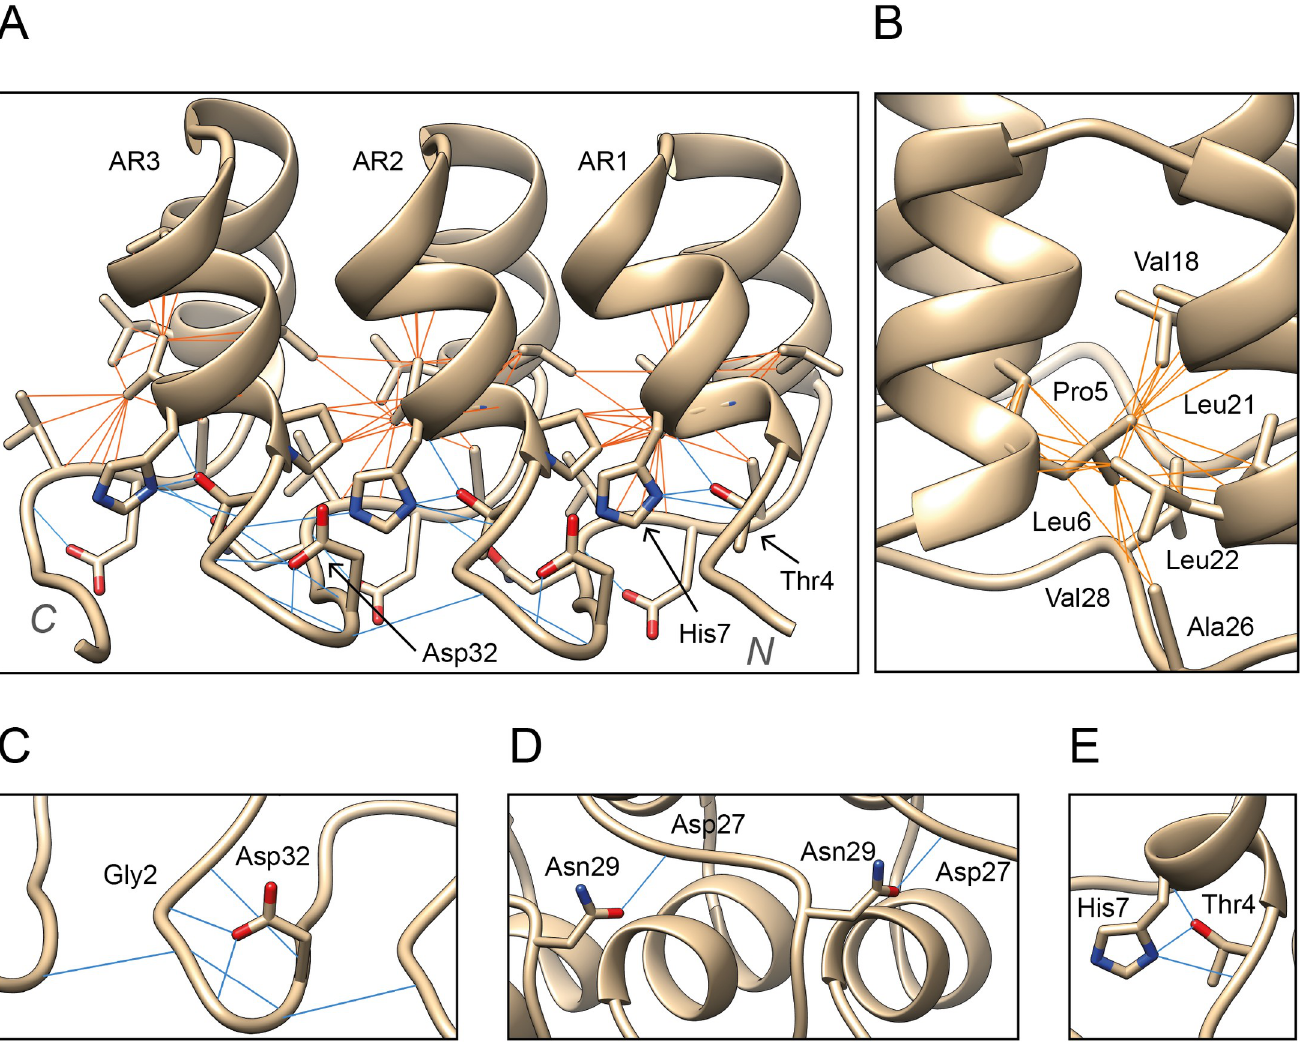
Fig 2. (A) Trio of ARs from a designed ankyrin repeat protein [14] (PDB: 5MA3). These three ARs display the main interactions responsible for the correct packing of the ARD. Hydrogen bond interactions are depicted by blue lines whereas hydrophobic ones are depicted in orange; (B) Hydrophobic network formed by Leu6 in the hydrophobic core of the domain; (C) Hydrogen bonding network at the β -turn between positions Asp32-Gly2; (D) Inter-repeat hydrogen bonds between conserved Asn29 and Asp27; (E) Thr4 forms three hydrogen bonds with His7. Structure visualization with UCSF Chimera